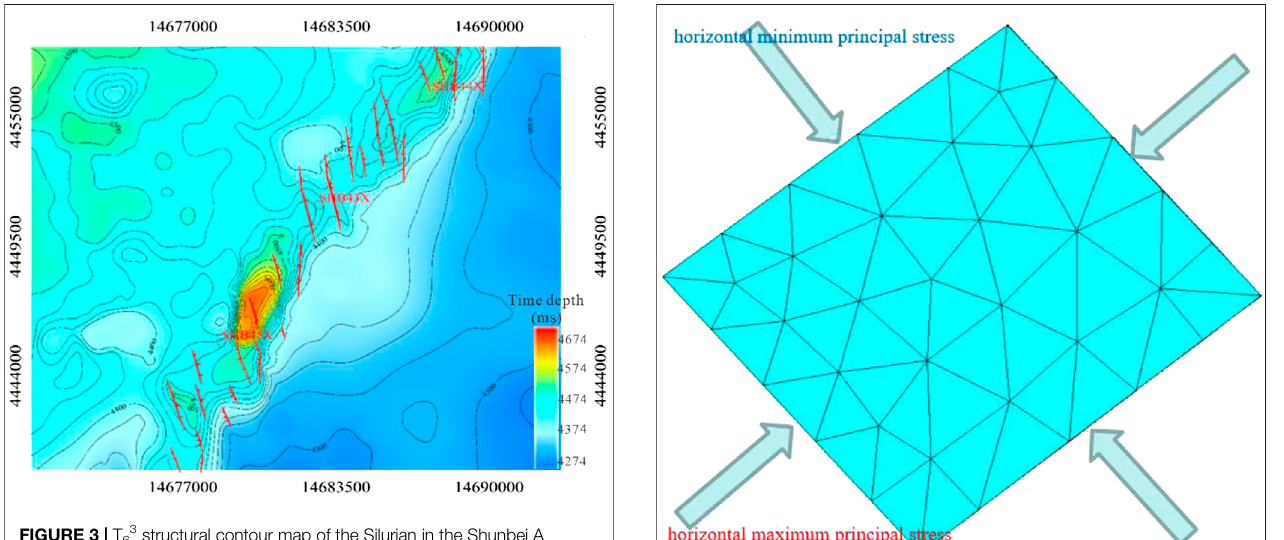
FIGURE 3 | T 63 structural contour map of the Silurian in the Shunbei A Strike-Slip Fault Zone in the Tarim Basin.